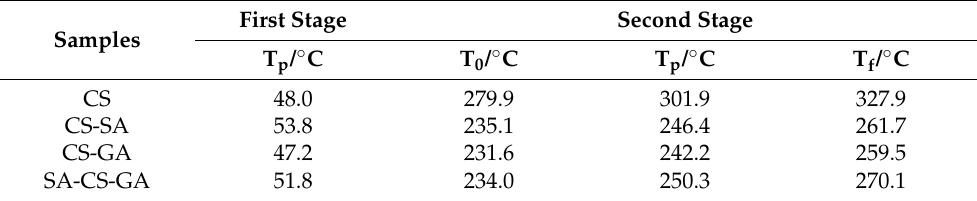
Figure 3. Thermogravimetric (TG) ( A ) and differential thermogravimetric analysis (DTA) ( B ) curves of chitosan (CS), chitosan-sialic acid (CS-SA), chitosan-18 β -glycyrrhetinic acid (CS-GA), and sialic acid-chitosan-18 β -glycyrrhetinic acid (SA-CS-GA). Table 2. Characteristic temperatures of thermal degradation of CS and its derivatives.